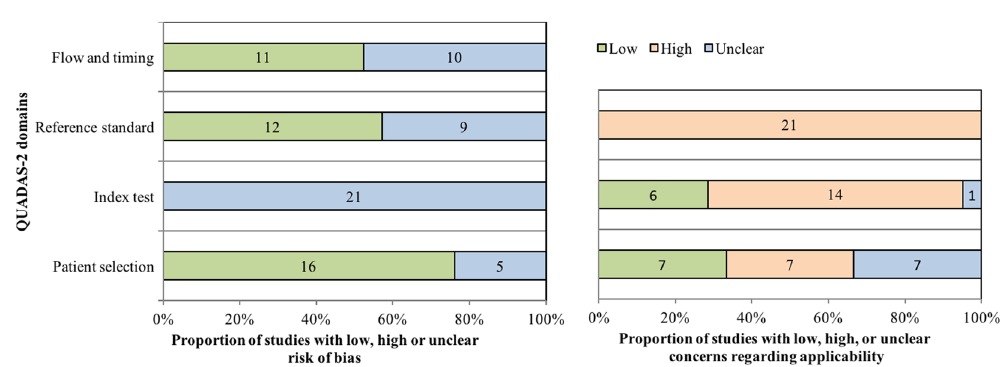
Figure 2. The methodological quality assessment of risk of bias within eligible studies according to QUADAS-2. QUADAS-2: Quality Assessment of Diagnostic Accuracy Studies